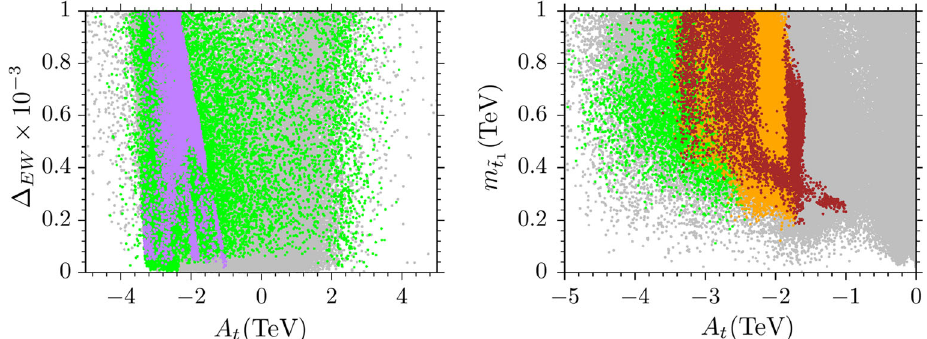
− A t planes. The color coding in the 1